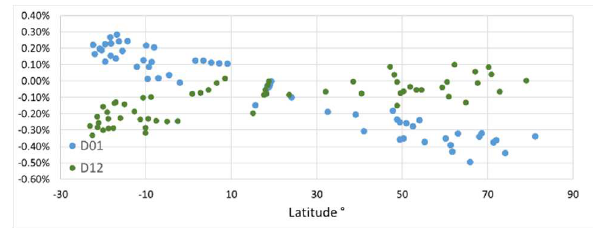
Figure 20 : Time delay errors vs latitude for D01 and D12 detectors. These errors are due to the fact yaw steering speed has not been taken into account.